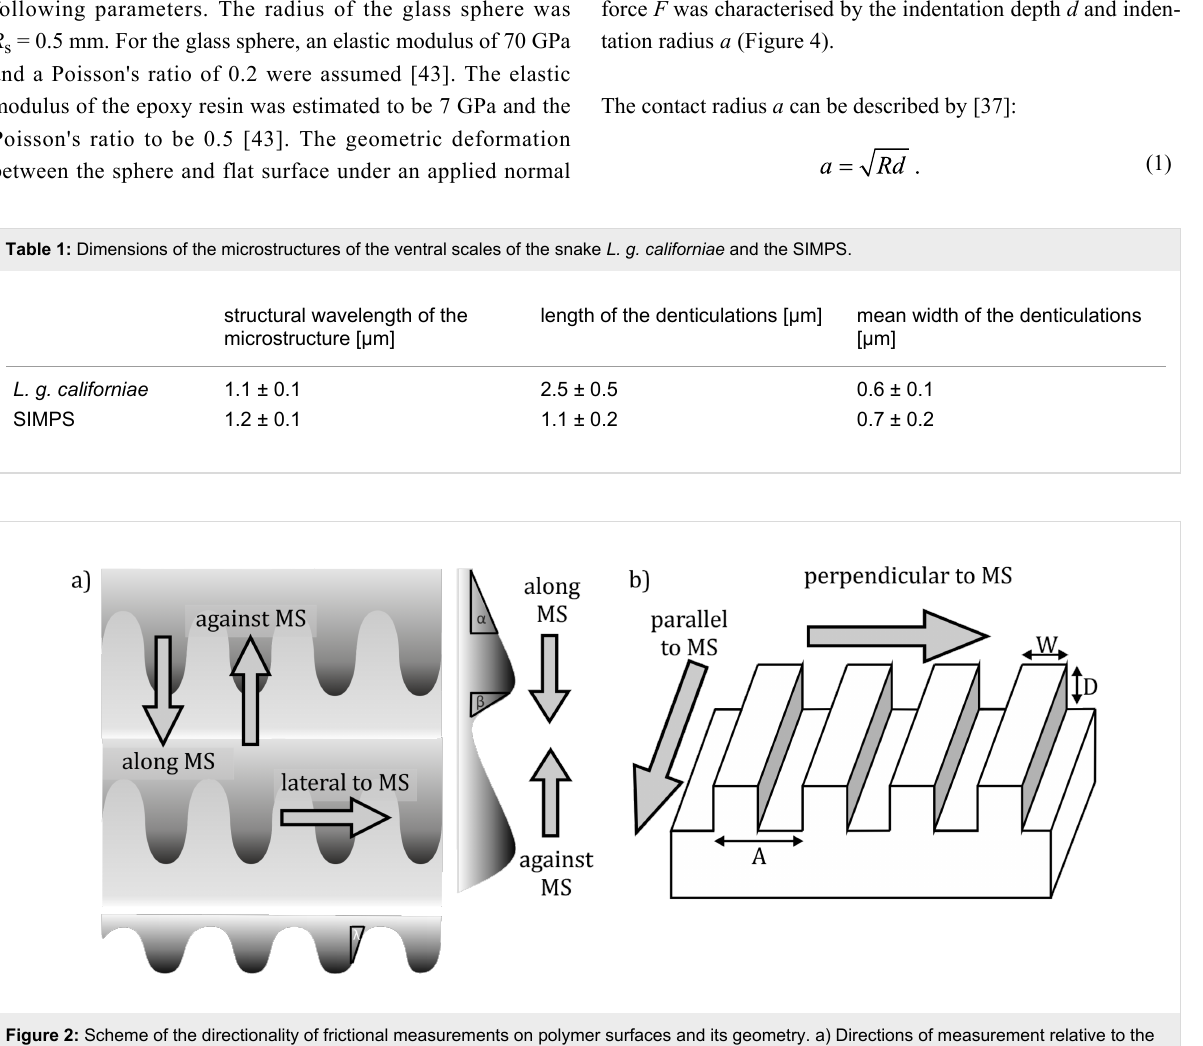
Figure 2: Scheme of the directionality of frictional measurements on polymer surfaces and its geometry. a) Directions of measurement relative to the topography of the SIMPS and angles of the microstructure depending on the measurement directions: α : along, β : against and λ : lateral to the microstructure. b) Diagram of the periodic groove-like profile. MS: microstructure, A : periodicity of the structure, W : width of the structure and D : depth of the grooves.